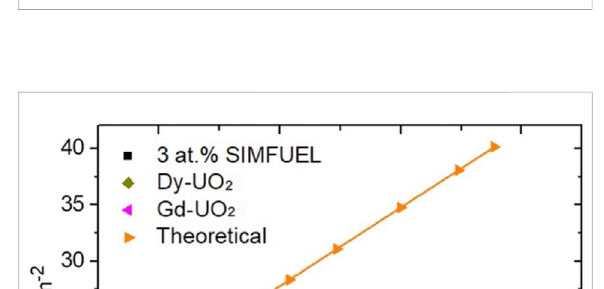
FIGURE 5 CVs recorded on the Gd-UO 2 electrode from − 1.2 V to different positive potential limits in a solution containing 0.1 mol.L − 1 of NaCl, 0.05 mol.L − 1 NaHCO 3 and 0.02 mol.L − 1 of H 2 O 2 (pH=9.7),electroderotationrate=8.33 Hz.Thecurves are offset by 5 mA cm − 2 for clarity with the zero current point indicated for the scan to 0 V.